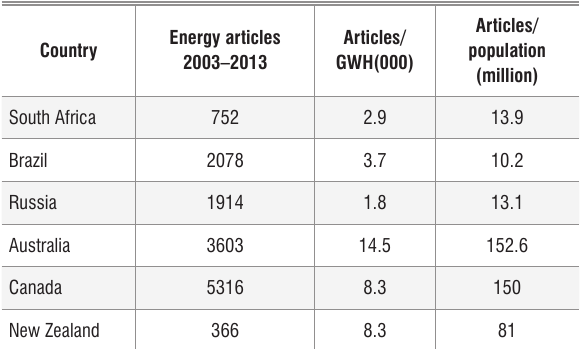
Table 9: Comparison of the number of Energy and Fuels articles from South Africa and comparator countries in 2003–2013 according to electricity production (GWH) and